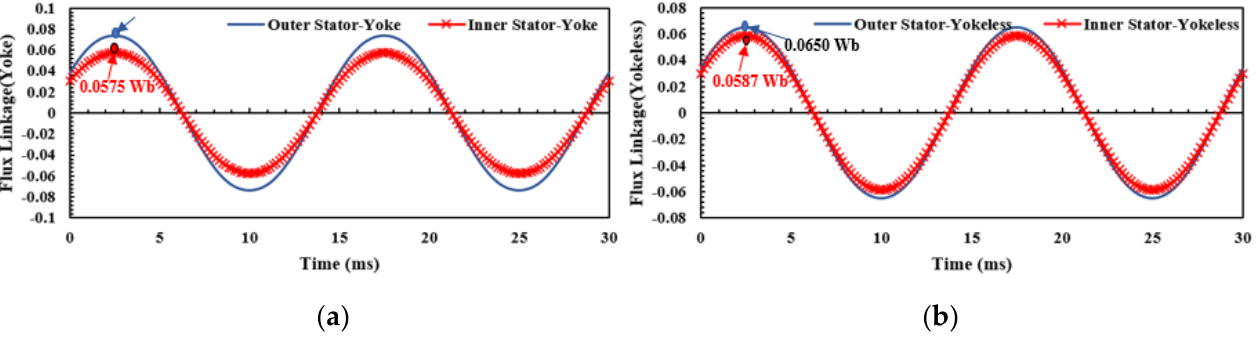
Figure 8. Flux linkage comparison in DARF-PMVM: ( a ) with iron yoke rotor, ( b ) without iron yoke (yokeless) rotor.